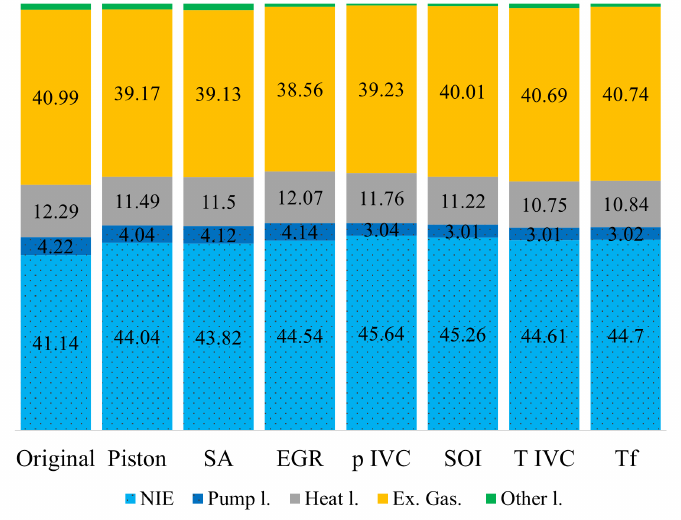
Figure 21. Influence of different parameters on the energy